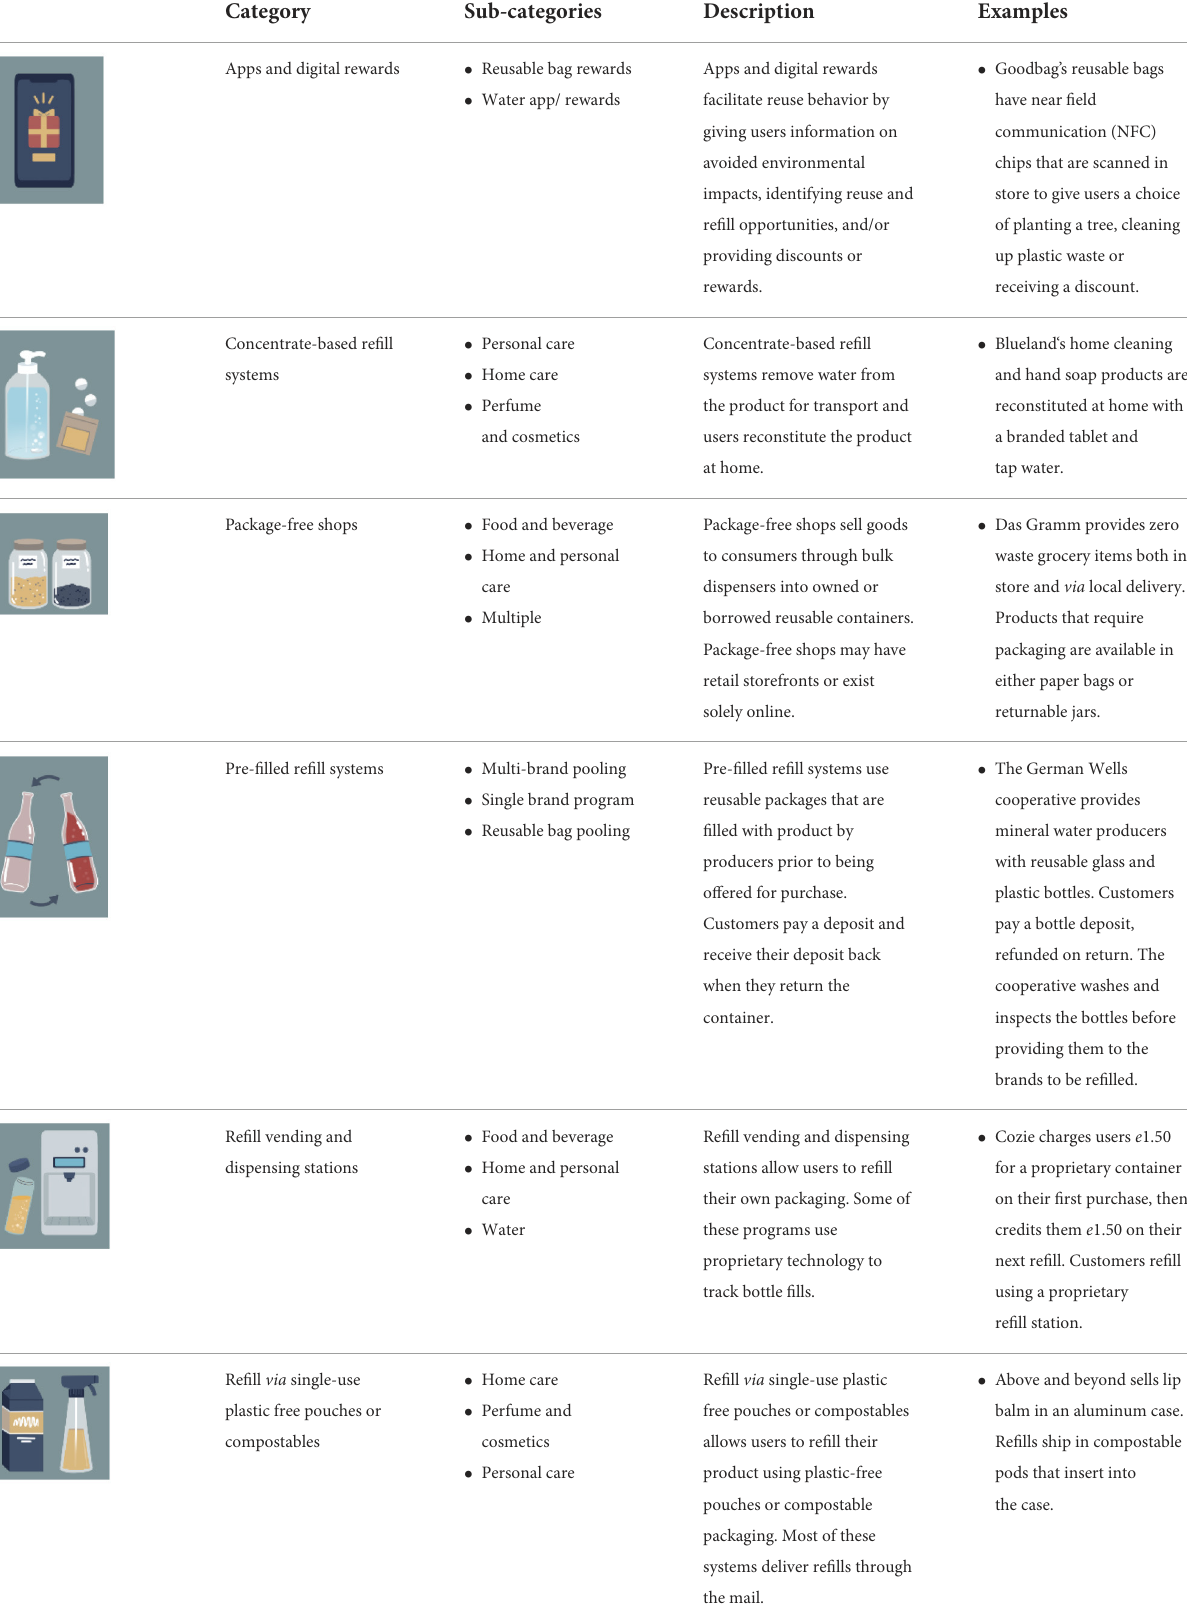
TABLE 1 Category definitions and